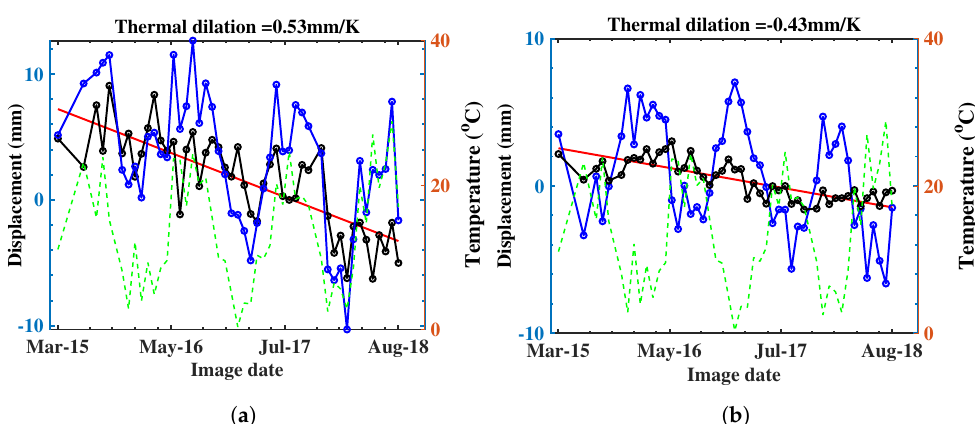
Figure 4. Displacement time series of two selected scatterers with strong thermal dilation: ( a ) the RMS of the displacement drops from 4.2 to 1.0 mm; and ( b ) the RMS of the displacement drops from 5.2 to 2.3 mm. Green dot line, temperature per acquisition; red line, linear deformation time series; blue line, deformation time series without temperature correction including linear deformation, nonlinear deformation, temperature motion and noise; black line, temperature-corrected deformation time series including linear deformation, nonlinear deformation and